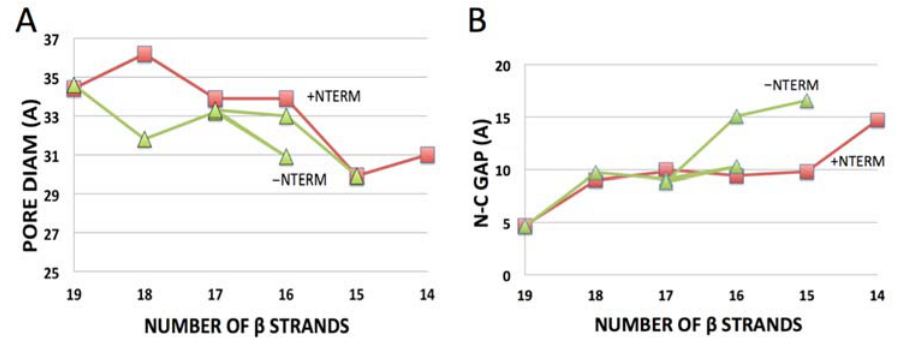
Figure 3. Systematic variation in ( A ) pore diameter and ( B ) “N-C gap” between β -strands at the N- and C-termini of Class I topologies with extent of domain truncation in hVDAC1 sequences. ( A ) Diameters measured as average of largest and smallest dimensions normal to the cylinder axis at the C α backbone near the middle of each β -barrel. ( B ) N-C gaps measured as described in Section 2.1 (data from Table 1).